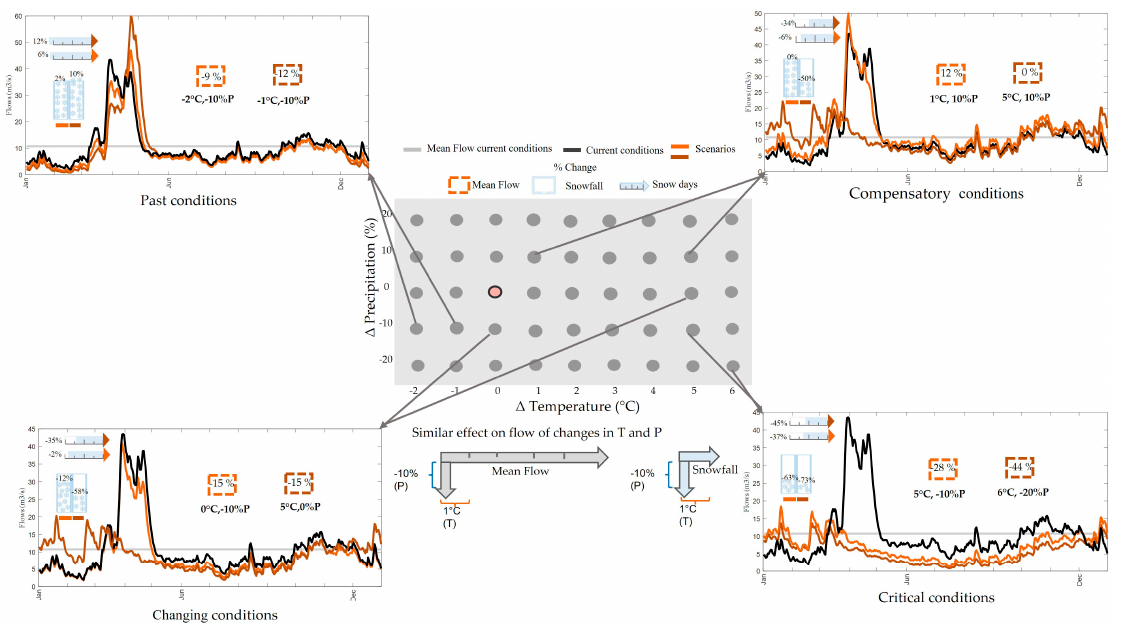
Figure 7. Mid–flow conditions and snow. In the center of the figure is the exposure space (explained in Figure 4), where arrows indicate which pairs of scenarios are referred to in each of the hydrographs. Below, represented by thick arrows, are the equivalent changes or compensatory scenarios in the vertical sense precipitation and in the horizontal sense temperature of the mean annual flows (gray) and snowfall (blue). Each graph shows the interannual hydrograph of recent conditions (black line) and of two evaluated scenarios (shown in orange colors, the darker one being the one with higher temperature and lower precipitation). The gray line represents the average flows of the current conditions. The values within the graph correspond to the percent change of each scenario concerning the current conditions. Within the dashed line boxes are the values of the changes in mean flows for each scenario. The percentage change of snowfall is represented by the light blue bars, where the white part represents the loss of snow and the part with snowflakes is the amount that remains. The percentage change of snow days is represented by the pencils, where the color of the tips represents the scenario to which it belongs, the light blue part represents the percentage of days with snow, and the white part is the decrease in days with